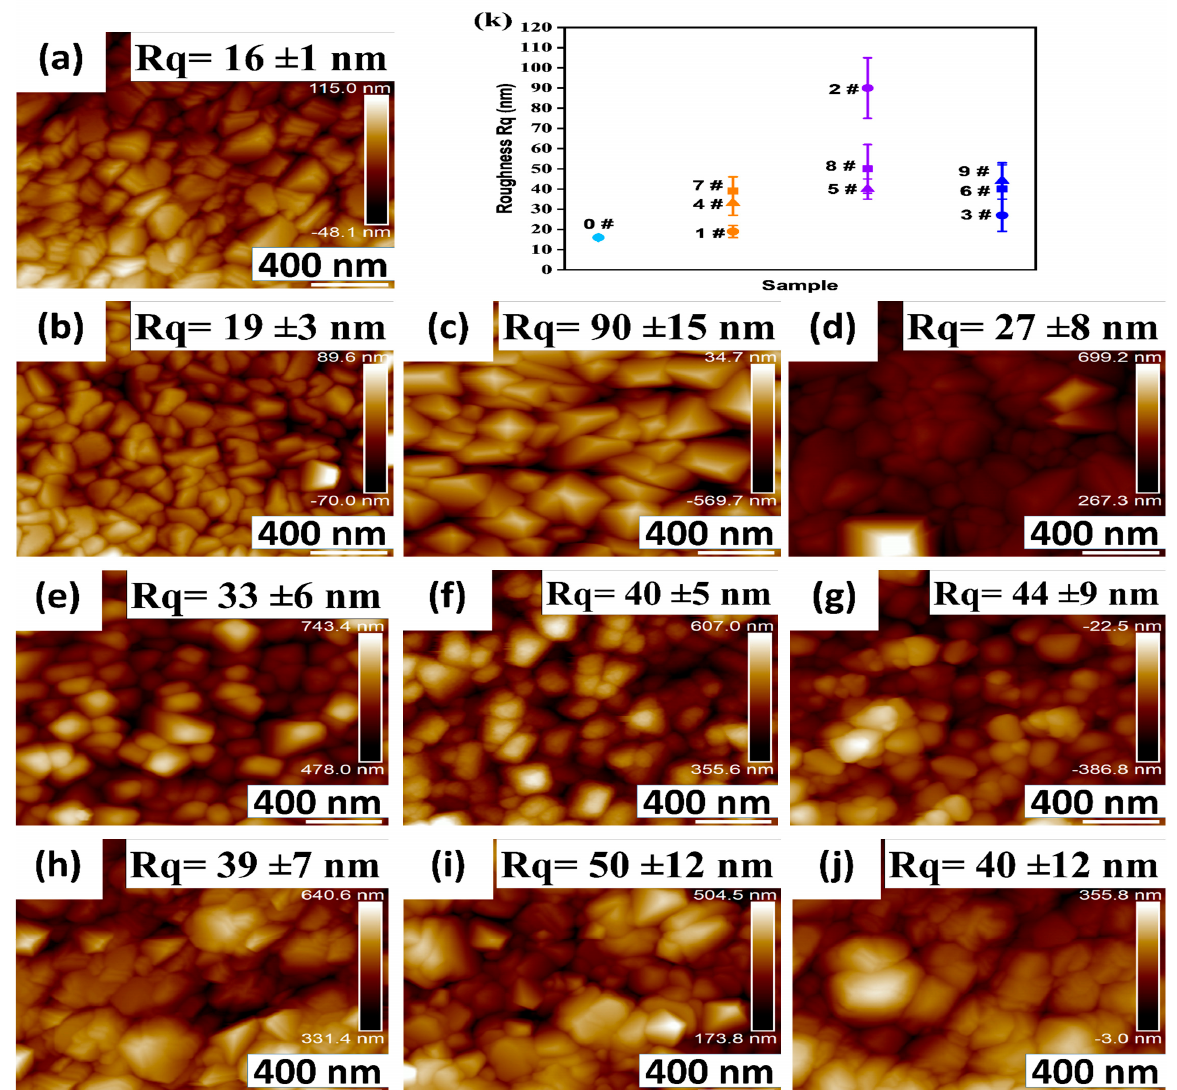
Figure 3. AFM surface images of ( a ) AlZr, ( b ) Al 2 O 3 /AlZr, ( c ) ZnO/AlZr, ( d ) TiO 2 /AlZr, ( e ) AlZr/Al 2 O 3 , ( f ) AlZr/ZnO, ( g ) AlZr/TiO 2 , ( h ) AlZr/Al 2 O 3 /AlZr, ( i ) AlZr/ZnO/AlZr and ( j ) AlZr/TiO 2 /AlZr; ( k ) represents the roughness variation of the different samples. The error bar be- longs to the standard deviation of the values.